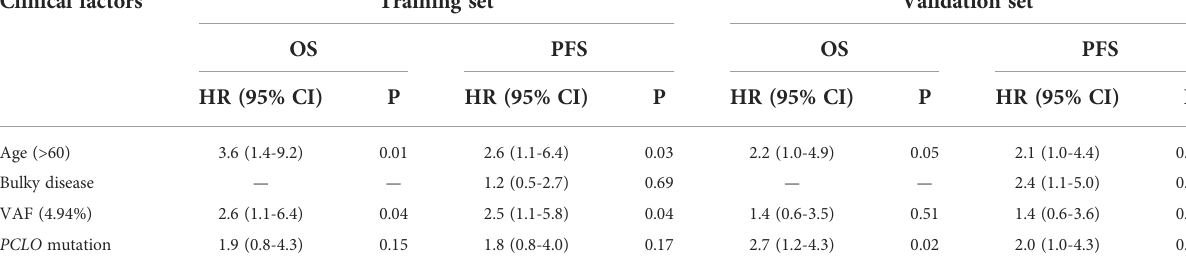
TABLE 4 Multivariate Cox analysis of the in fl uencing factors of PFS and OS in the training set and validation set. Clinical